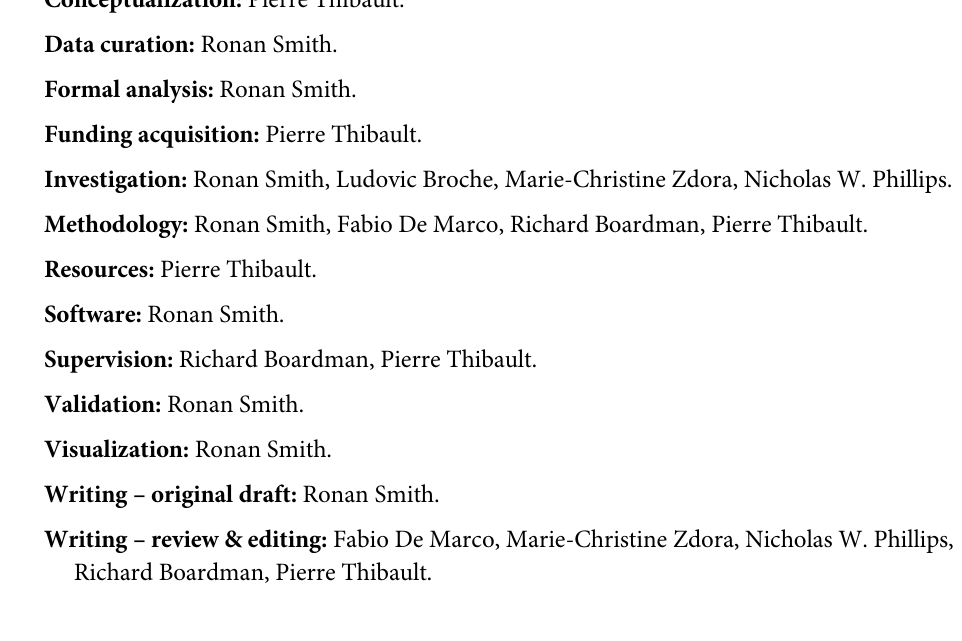
unbinned detector, and the geometric magnification set to give a pixel size of 1.03 μ m. The accelerating voltage was 80 kV and the power was 7 W. 4501 projections with 10 s of exposure were taken. A radial slice was taken with the internal edge of the tube shown in the top part of the figure. The fibres can be seen to run parallel to this edge. The bright spots in the image are tiny pieces of dense material (most likely metal shavings) which have been accidentally intro- duced during the manufacturing process but should not effect the dark field signal. Moire fringes are visible showing there are some slight deviations in the fibre orientation orthogonal to the slice. S2 Fig. Transverse tomogram slice. A radial slice taken from the tomogram described above, showing that beside a few small regions, the overall fibre density within the sample is fairly uni- form. There is a slightly lower density of fibres in the region near the edge, and in some small regions in the center of the field of view where a contaminant particle can be